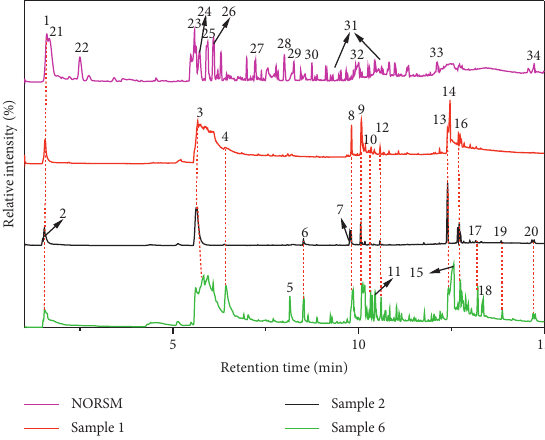
Figure 8: GC of pyrolytic products of the samples.